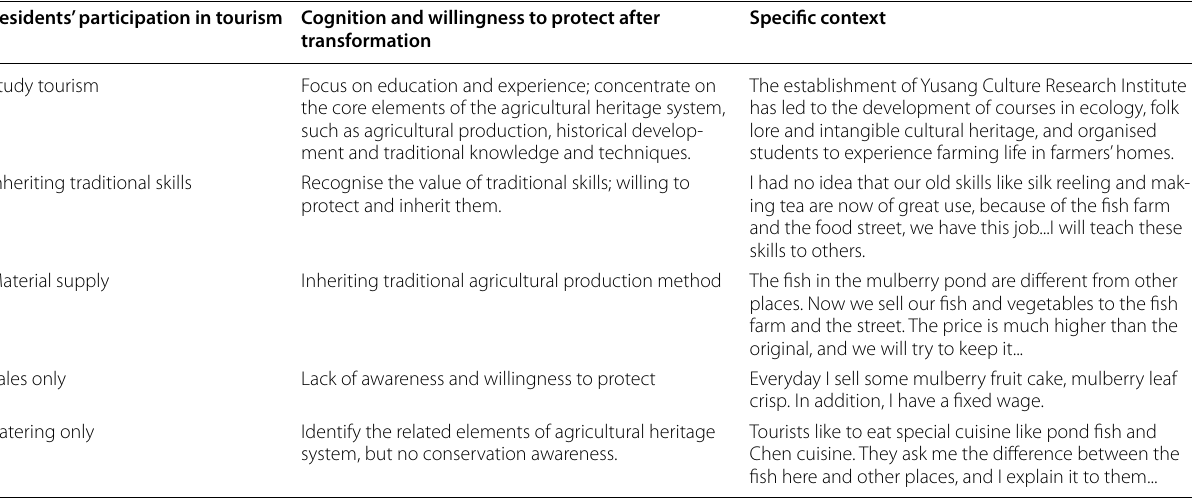
Table 4 Residents’ cognition after the transformation of Digang Food Street Residents’ participation in tourism Cognition and willingness to protect after